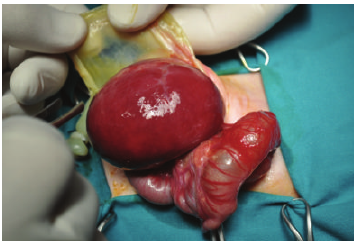
Figure 1: The hernia sac containing the whole liver and part of the large and small intestine.